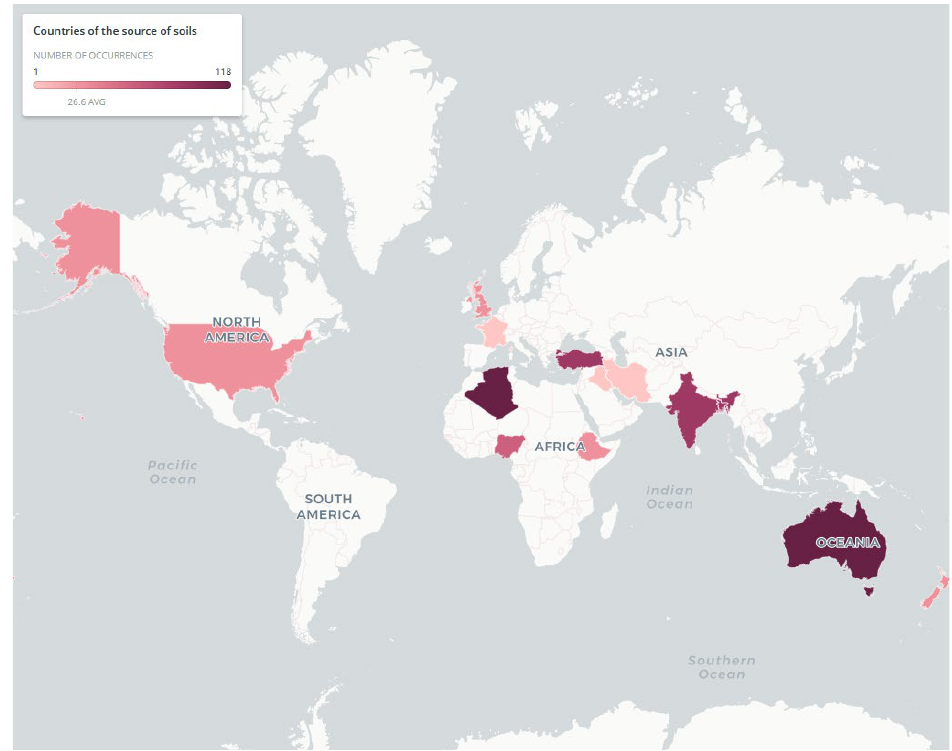
Figure 1. Distribution of experimental data in multiple locations globally.